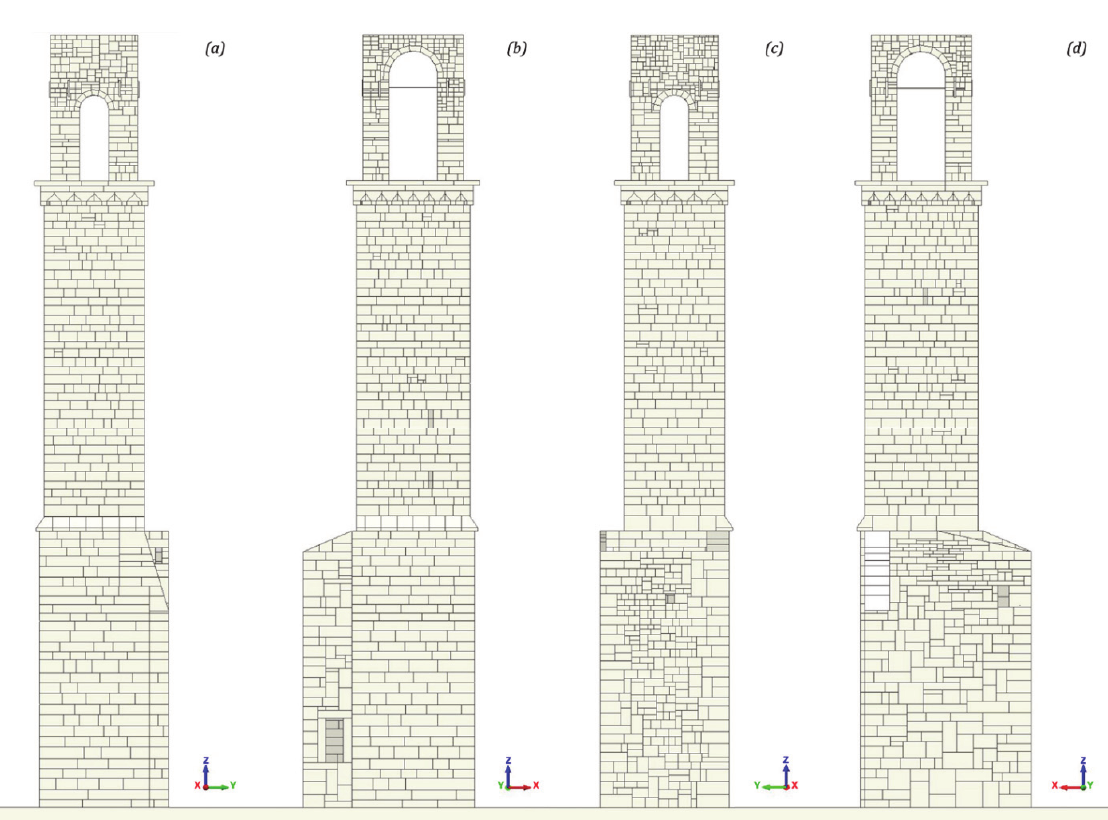
Figure 9: Views of the North façade (a), East façade (b), South façade (c), West façade (d) of the numerical model with steel chains of the civic clock tower of Amatrice (Rieti, Italy) with the NSCD